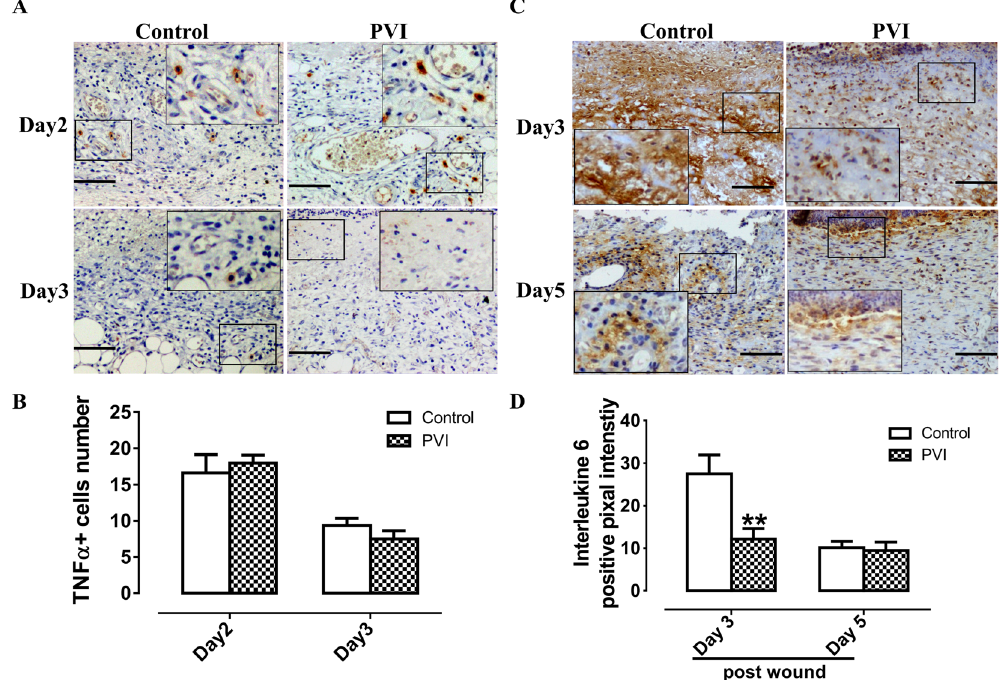
Figure 6. The effect of povidone-iodine (PVI) treatment on tumor necrosis factor (TNF) α and interleukin (IL) -6 expression at the wound site. ( A ) Representative immunohistochemical TNF α stained wound sections. Scale bar = 50 μ m. ( B ) Semi-quantitative analysis of TNF α + cells (/high power fields). ( C ) Representative immunohistochemical IL-6 stained wound sections. Scale bar = 50 μ m. ( D ) Semi-quantitative analysis of IL-6 expression. ** p < 0.01 vs control. Data are means ± S.D, n = 24.